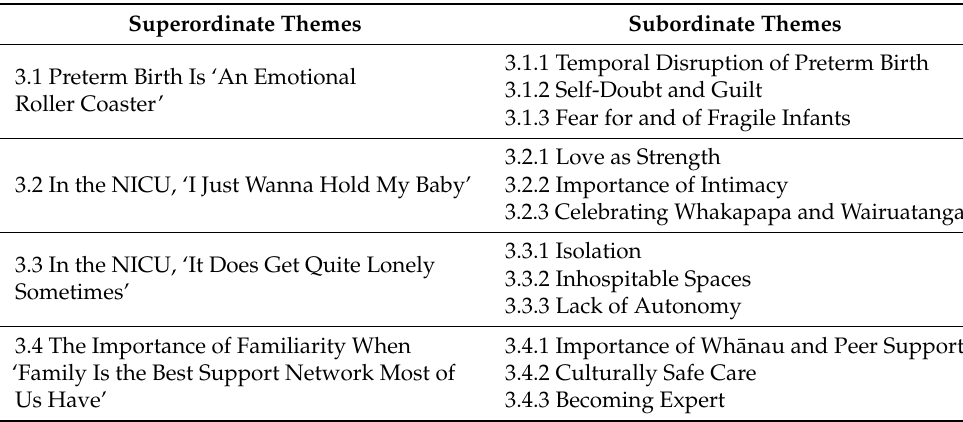
Table 2. Superordinate themes and subordinate